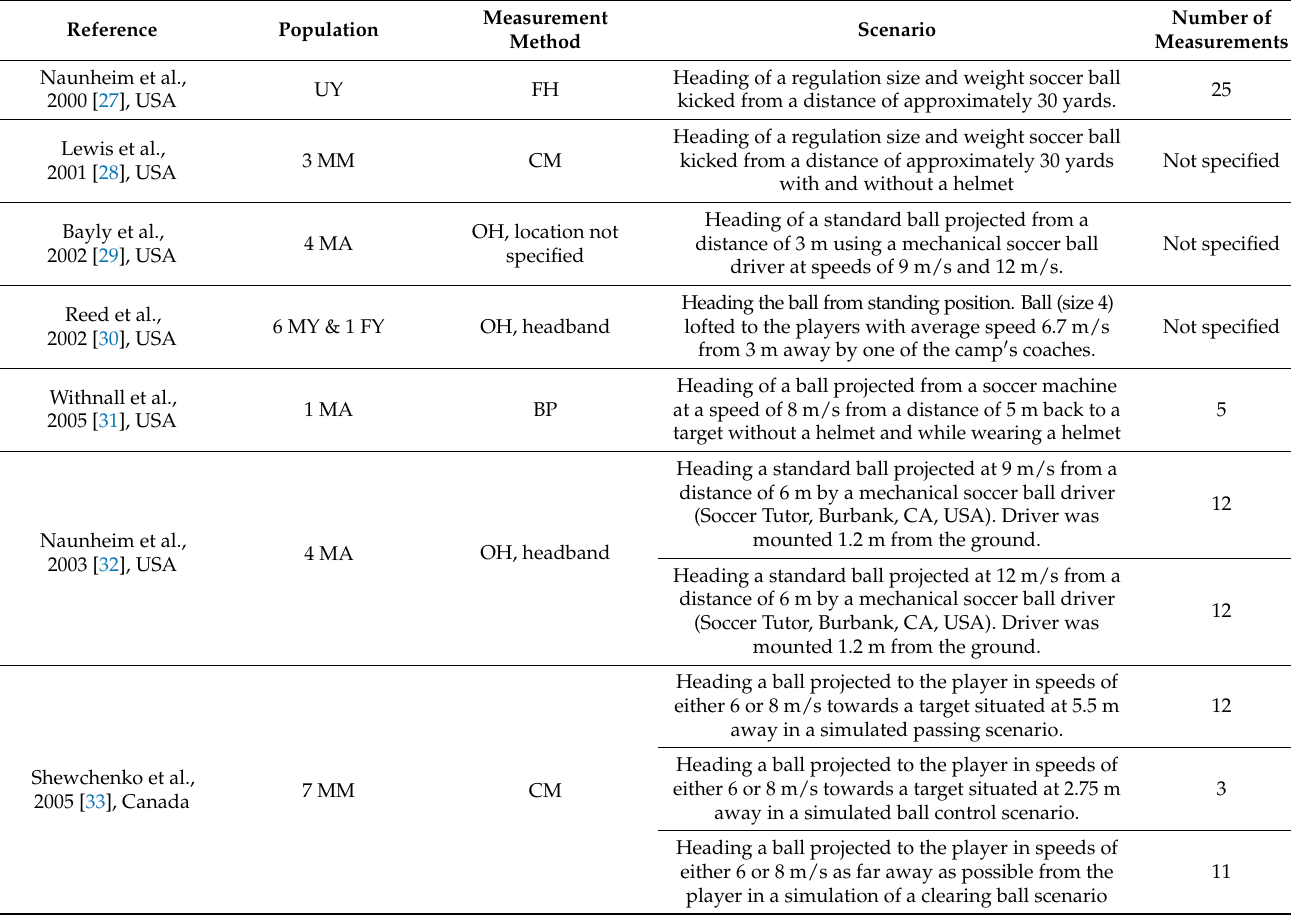
Table 2. Experimental studies reporting peak linear and rotational accelerations due to heading and other head